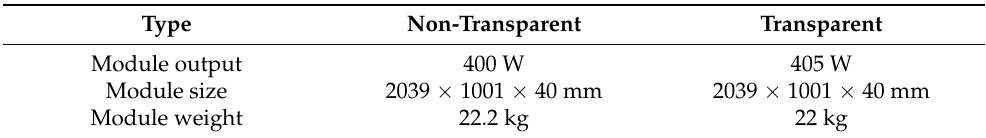
Table 1. Physical characteristics of PV modules.